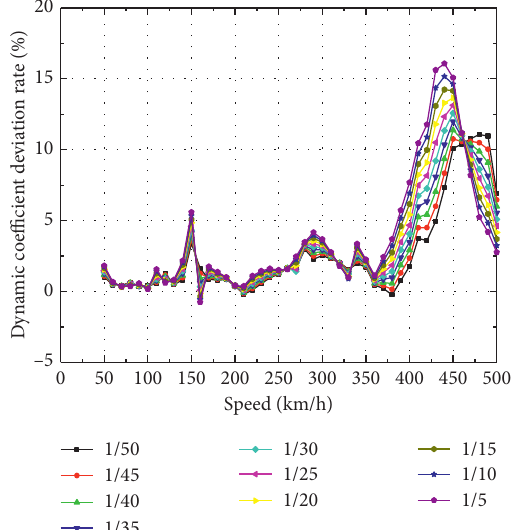
Figure 14: Dynamic coefficient deviation rate of the bridge under the moving load model.